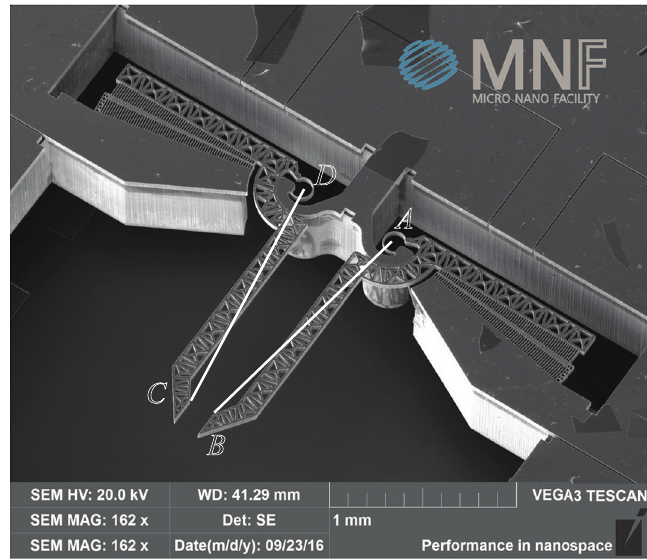
Figure 2. Scanning Electron Microscope (SEM) image of the first microgripper prototype, developed with the simple structure two joint-2 jaws and with two degrees of freedom (white solid lines AB and DC correspond to rigid links, which rotate around the fixed points A and D , respectively).